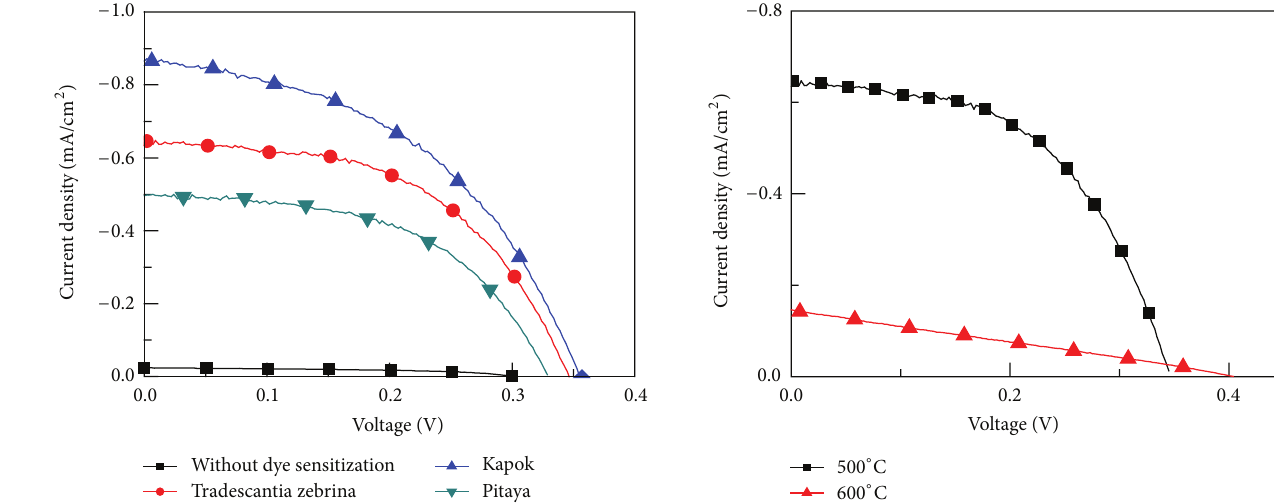
Figure 4: J-V characteristics of DSSCs sensitized with three kinds of natural dyes under illumination of 50mW/cm 2 , compared with the solar cell without dye sensitization.